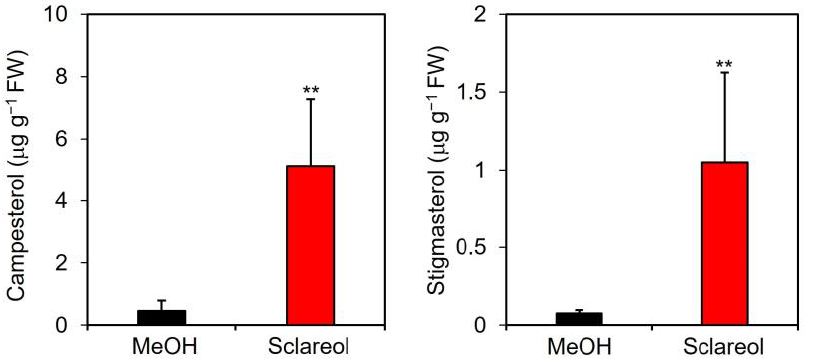
Figure 4. Effects of exogenous sclareol on the accumulation of campesterol and stigmasterol in Arabidopsis leaves. Arabidopsis plants were treated by soaking their roots in a solution containing 100 µ M sclareol for 48 h. The leaves of the treated plants were collected and subjected to the measurement of campesterol and stigmasterol. As a control, 0.1% methanol (MeOH) was used. Values are the means ± standard deviation of three biological replicates. Asterisks denote significant differences from the 0.1% methanol sample ( t -test, ** p < 0.01). The experiment was repeated three times with similar